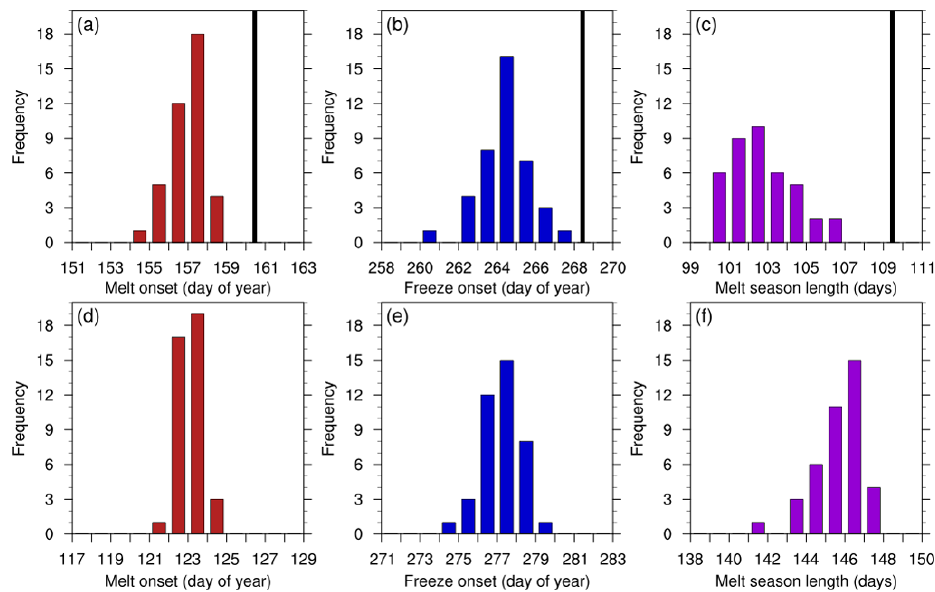
Figure 2. Histograms of the pan-Arctic average melt season characteristics over 1979–2014 using the surface temperature definitions (a–c) and thermodynamic ice volume tendency definitions (d–f) for all 40 CESM LE ensemble members, showing the impact of internal variability. PMW observations are denoted by black lines (a–c) . Note that the x -axis limits are different in each panel, but the range is the same (12 days), to facilitate the assessment of the impact of internal variability for different processes and